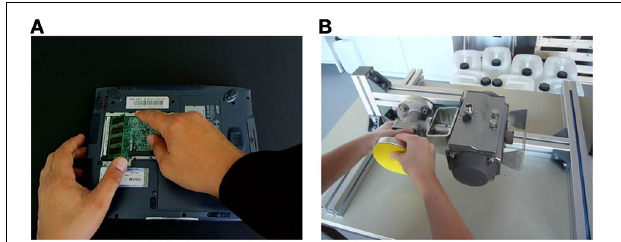
FIGURE 4 | Screenshots of (A) a maintenance task of installing a new notebook RAM and (B) an industrial manual task in which parts of a pump system are